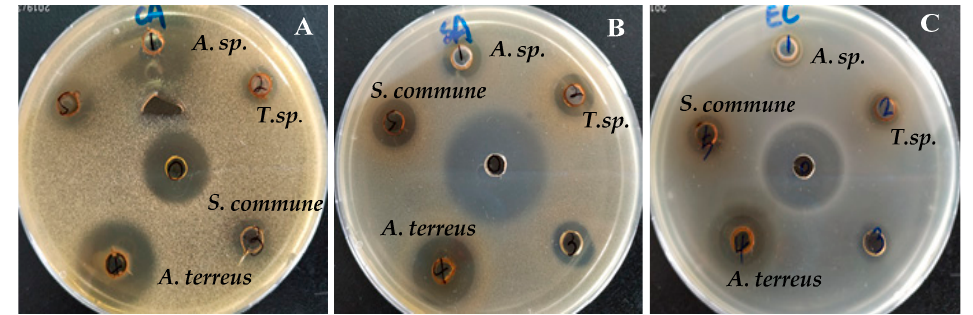
Figure 2. Antimicrobial activity of fungal endophytes from V. anthelmintica against some pathogenic fungus C. albicans ( A ) and bacteria S. aureus ( B ) and E. coli ( C ) .